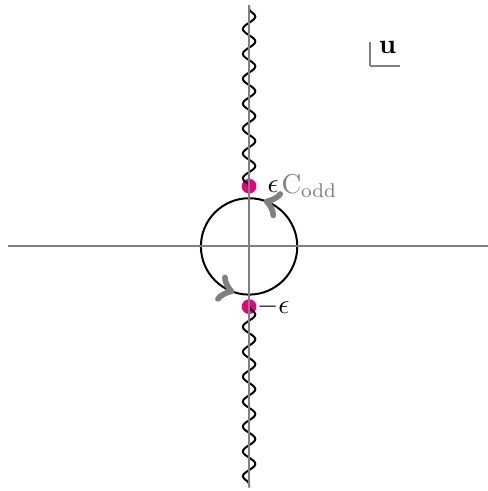
Figure 4. Contour C odd in the u -plane for even AdS d